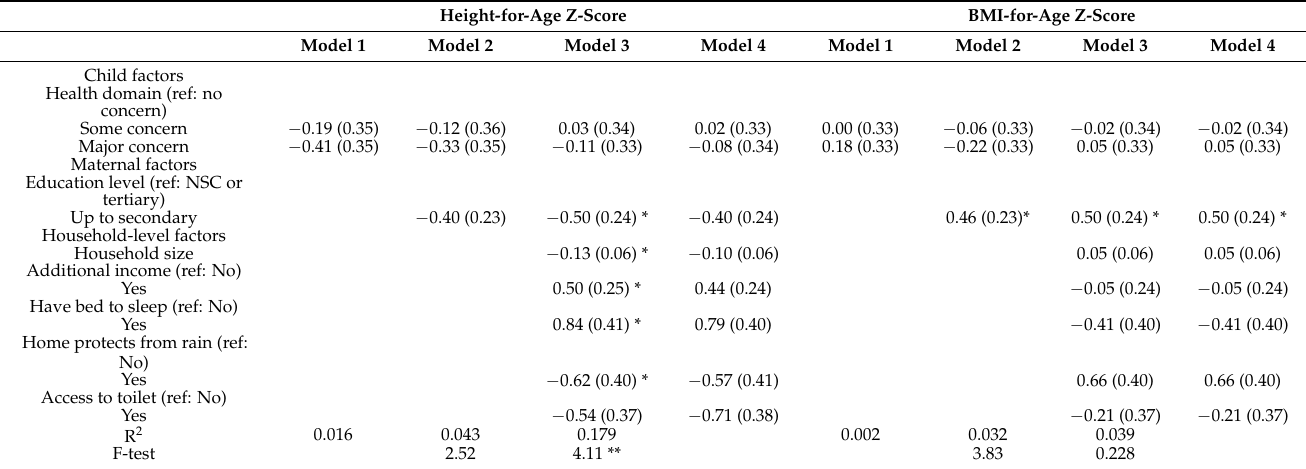
Table 5. Individual- and household-level factors that are associated with child growth outcomes with adjustment for community level factors using school classification (fee-paying or non-fee-paying).